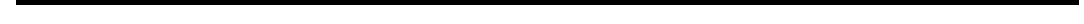
Fig. 2 – The lizard medial cortex connections. A: Horseradish peroxidase (HRP) anterograde labelling of the outermost strata of the outer plexiform layer (‘‘lizard perforant path’’) of the medial cortex after HRP injection in the ipsilateral lateral cortex, B: HRP anterograde labelling of the medial cortex cell layer juxtasomatic strata after massive injection of HRP in the contralateral hemisphere (‘‘lizard commissural path’’); notice also the heavy retrograde labelling of the principal neurones of the dorsomedial cortex and those of the medial edge of the dorsal cortex. C: Intracellular injection of HRP in a principal neurone of the dorsomedial cortex which emits a commissural axon. D: Idem, enlarged view of the injected neurone showing its bipyramidal aspect. E: Timm stained (for vesicular zinc) and toluidine blue counterstained lizard cortex transversal section showing the vesicular zinc enriched fields as dark zones where metallic silver has been precipitated. F-G: Idem, one micron semithin section roughly showing a zone marked by a square in E; observe the punctate appearance of the Timm reaction in the plexiform layers. H: Electron microscope aspect of the Timm reaction; silver granules appear grouped onto some presynaptic boutons. I-J: Timm positive presynaptic boutons as seen after sulphide-osmium treatment for zinc detection; observe the electrondense zinc precipitate inside synaptic vesicles and the big size of boutons which synapse dendritic spines and may completely surround them. (Scale bar represents 100 µ m in A, 150 µ m in B, 300 µ m in C, 75 µ m